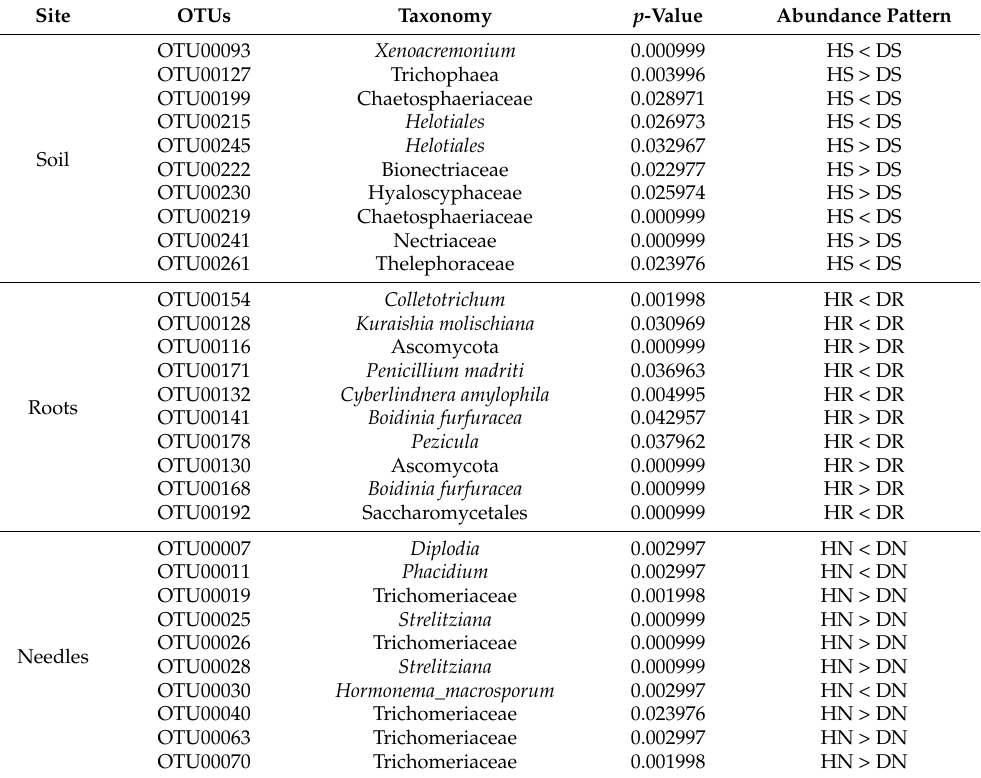
Table 1. Top 10 (> 0.1%) most abundant OTUs showing significant differences in soil (S), roots (R), and needles (N) around and of healthy (H) and diseased (D) trees.